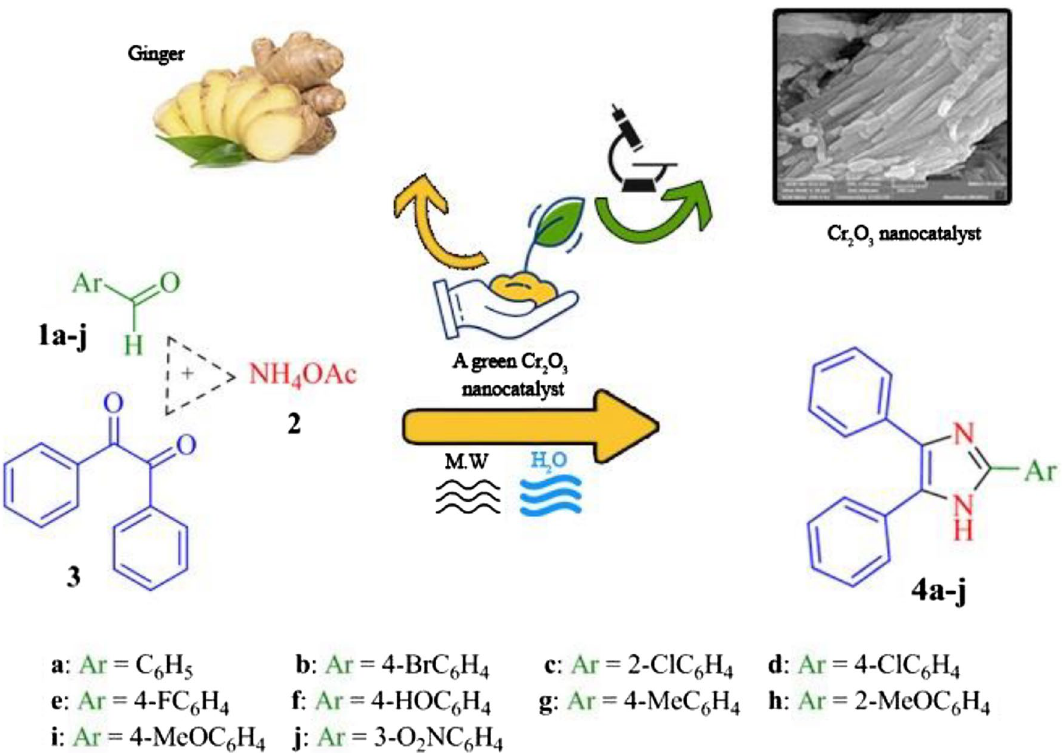
Figure 3. Synthesis of imidazole derivatives 4a–j with Cr 2 O 3 as catalyst under microwave